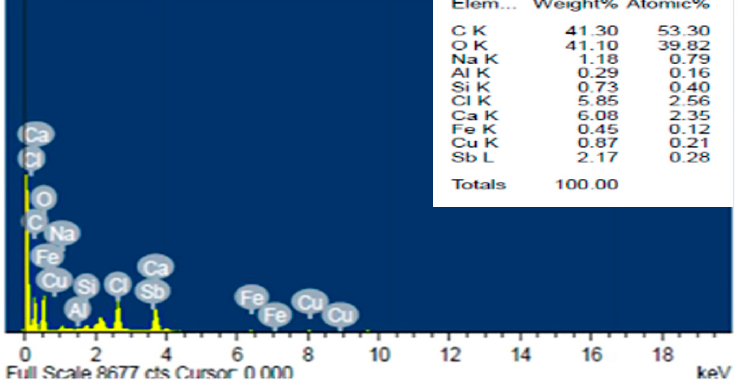
Polymers 2023 , 15 , x FOR PEER REVIEW 12 of 24